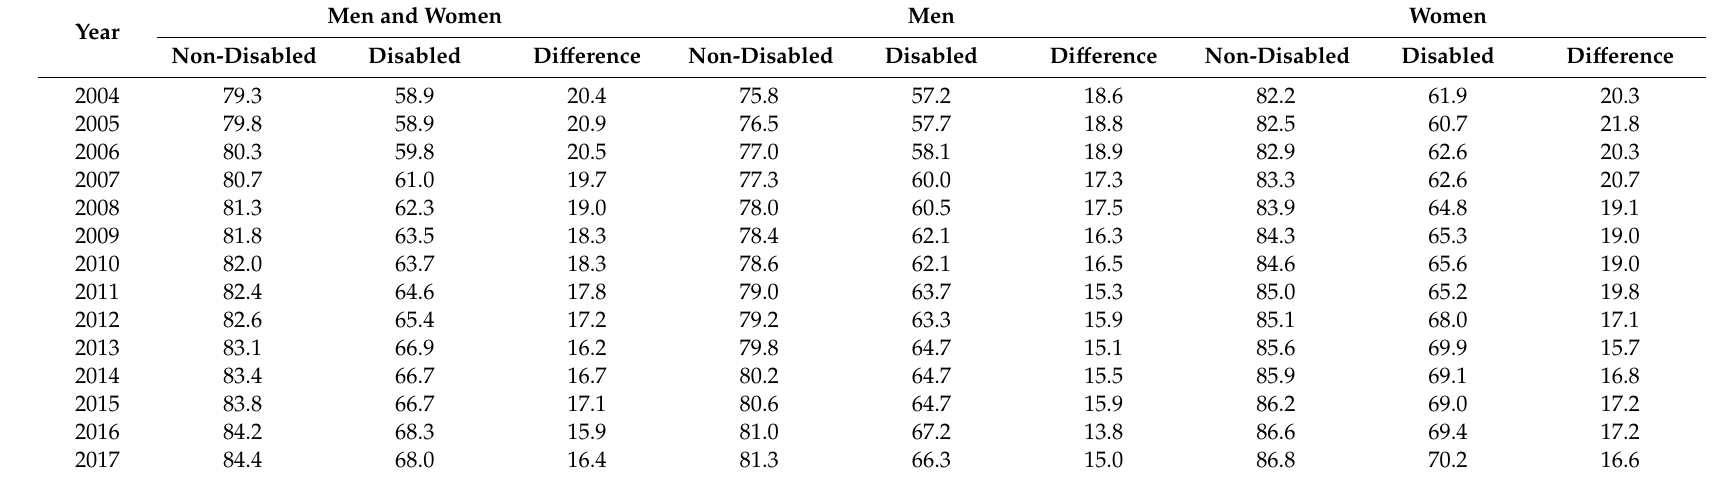
Table 1. Annual life expectancy among non-disabled and registered disabled people in Korea between 2004 and 2017 by